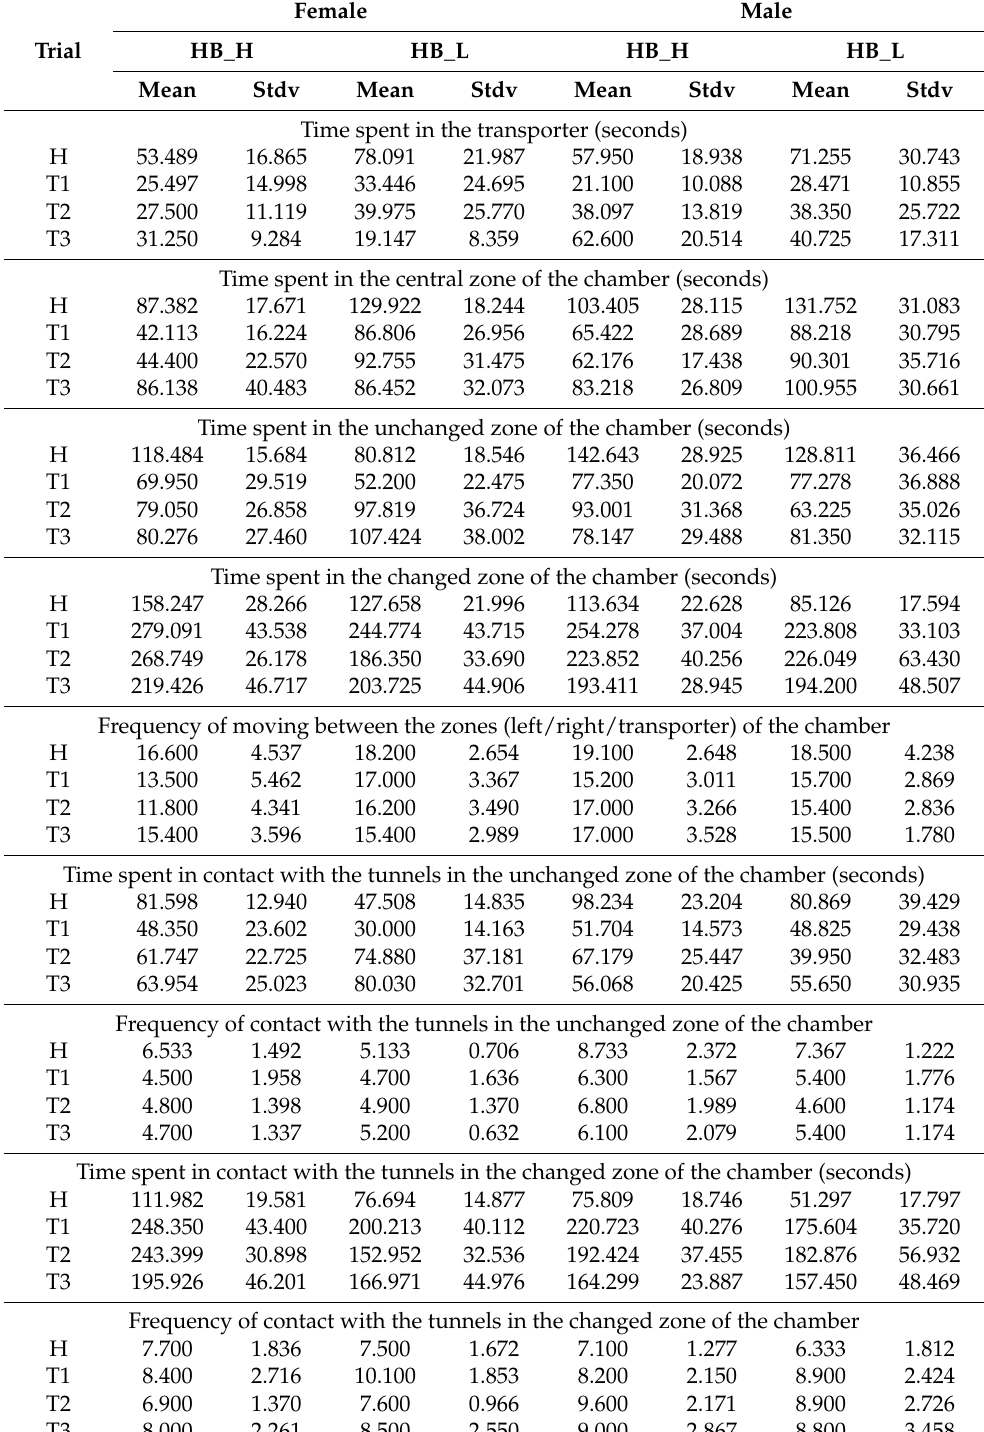
Table 2. Descriptive statistics of the variables analyzed in the free-exploration test (Phase